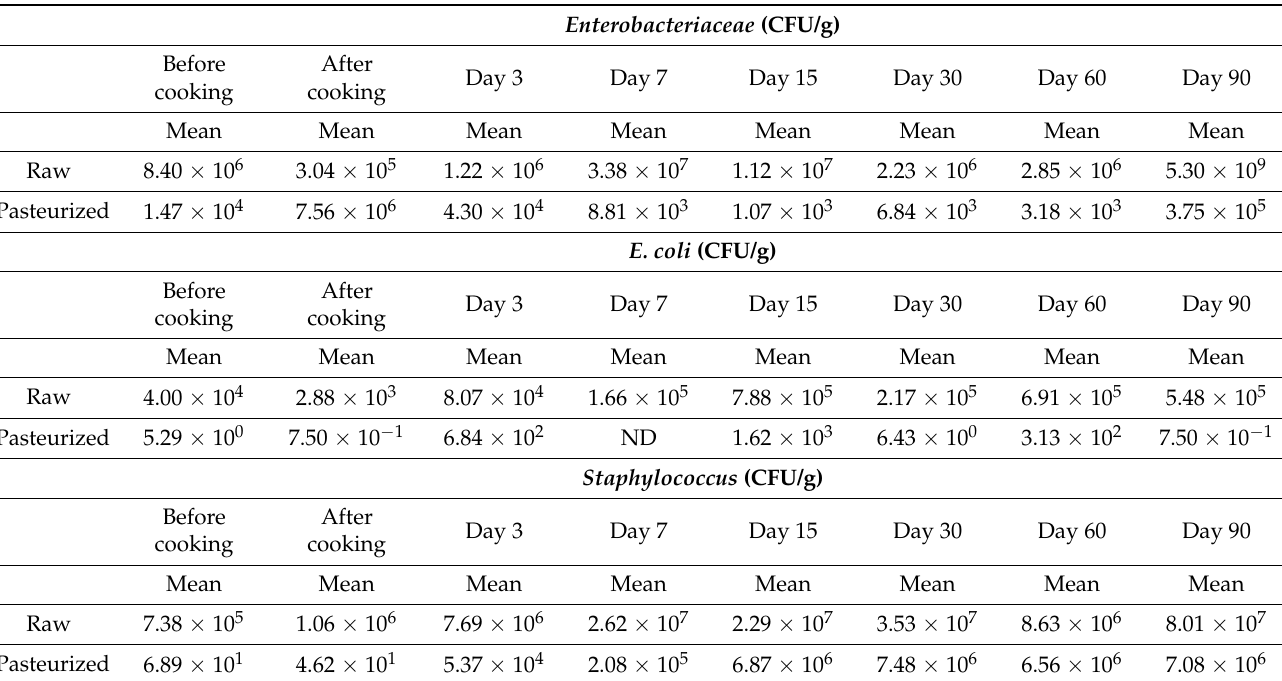
Table 2. Enterobacteriaceae, E. coli , and Staphylococcus spp. counts in raw and pasteurized curd and cheese samples (geometric